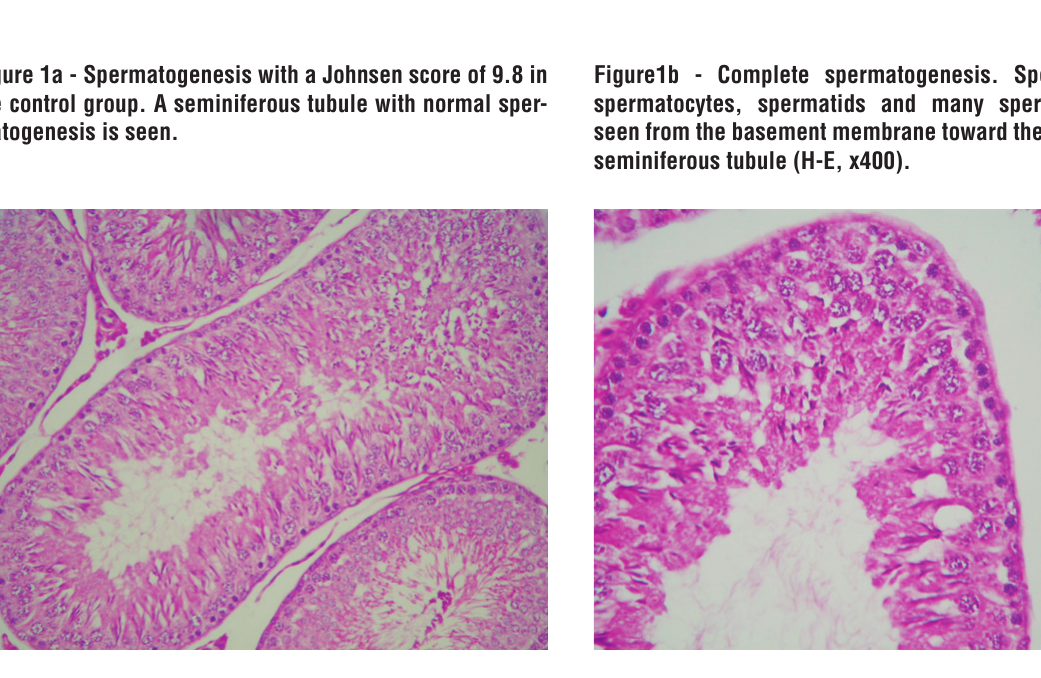
Fluoxetine Escitalopram Paroxetine